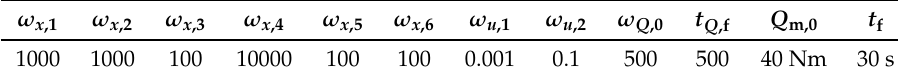
Table 2. Parameters used by the parametric optimal controller.